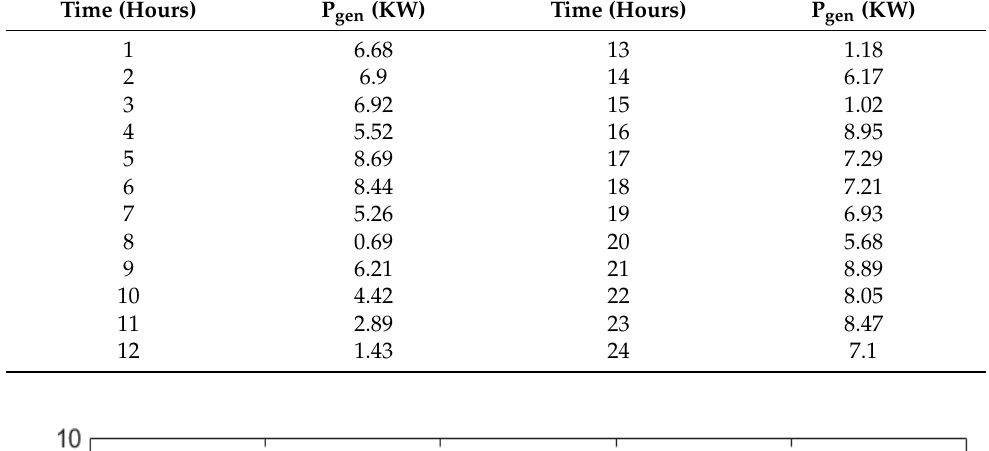
Figure 7. Initial total demand.